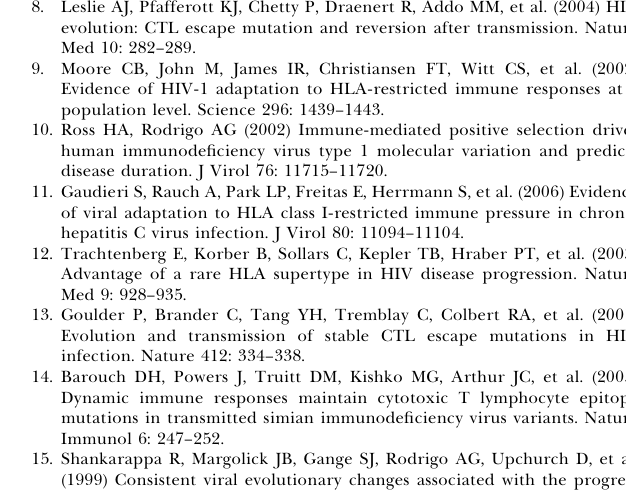
Figure S2. Mixture Frequency Distributions The histograms depict frequency distributions for nonsynonymous (above) and synonymous (below) mixtures per codon position. Note that the histograms for HCV E1 and E2 (HVR1) are on different scales. There is conspicuously greater variation among codon positions in nonsynonymous mixture frequencies, more notably in HIV-1 sequen- ces. Codon positions associated with peaks in the frequency of nonsynonymous mixtures are indicated above each distribution by the alignment consensus amino acid and residue number. Found at doi:10.1371/journal.ppat.0030045.sg002 (169 KB PDF). Figure S3. Effect of Mutation Rate Asymmetry on the Frequency of Escape Mutations A contour plot depicting the difference ^ p (cid:4) q as a function of the disparity in selection coefficients and mutation rates between HLA þ and HLA (cid:4) hosts ( r ¼ log 10 ( s esc ) (cid:4) log 10 ( s rev ) þ log 10 l (cid:4) log 10 m ) and the transmission rate (log 10 k ). When the net effect of mutation and selection is equivalent between HLA þ and HLA (cid:4) hosts ( r ¼ 0), then ^ p converges to q and is independent of variation in transmission rate. In contrast, when there is a net imbalance in mutation and selection ( r 6¼ 0), there is a departure of ^ p from q ; this departure becomes greater with increasing transmission rates. Viral population size has no apparent effect on the difference ^ p (cid:4) q . Each open circle corresponds to a replicate simulation with unique parameter values set by Latin hypercube sampling. Figure S4. Comparison of Stochastic Simulation and Model Pre- dictions Scatterplot illustrating correspondence between predicted value of p from the deterministic model ( x -axis) and values obtained from simulations at equilibrium ( ^ p , y -axis). A solid line is drawn at x ¼ y to indicate an exact match between model and simulation frequencies. Dashed lines above and below the x ¼ y axis enclose variation in frequencies within a 6 10% interval. Disparity between the model and simulations is caused by a lack of stochastic factors in the model. Replacing the unidirectional mutation approximations of the model ( p HLA þ and p HLA (cid:4) ) by the exact formula has no visible effect on the correspondence between the model and simulations. Figure S5. Frequency Distributions of Pair-Wise Distances of HIV-1 and HCV